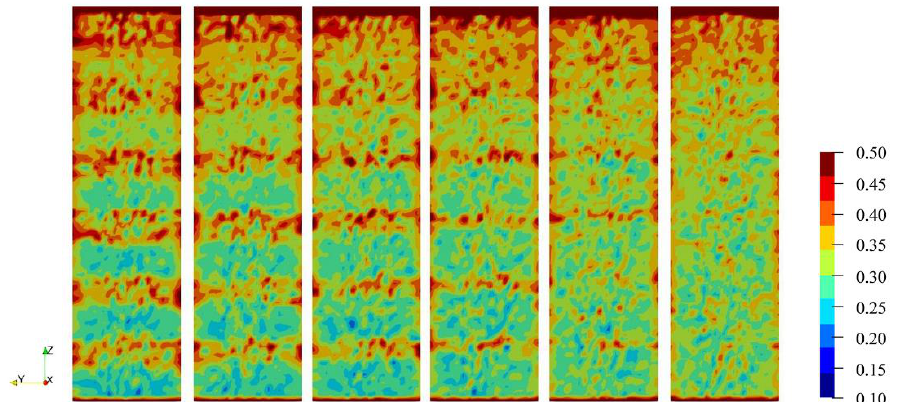
Figure 15. Void fraction variances of stock columns under different coke mixing ratios.